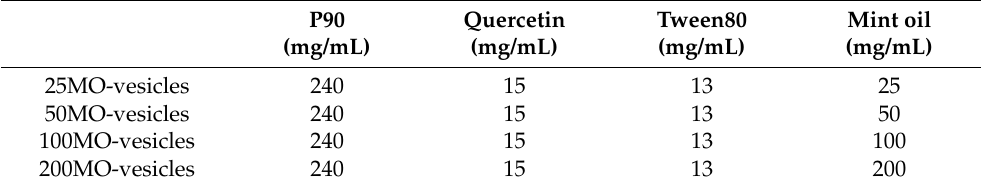
Table 1. Composition of quercetin and mint oil-loaded vesicles prepared with phospholipon 90 (P90) and Tween 80, and hydrated with a mixture of phosphate buffer, propylene glycol and ethanol (1:1:1 v / v